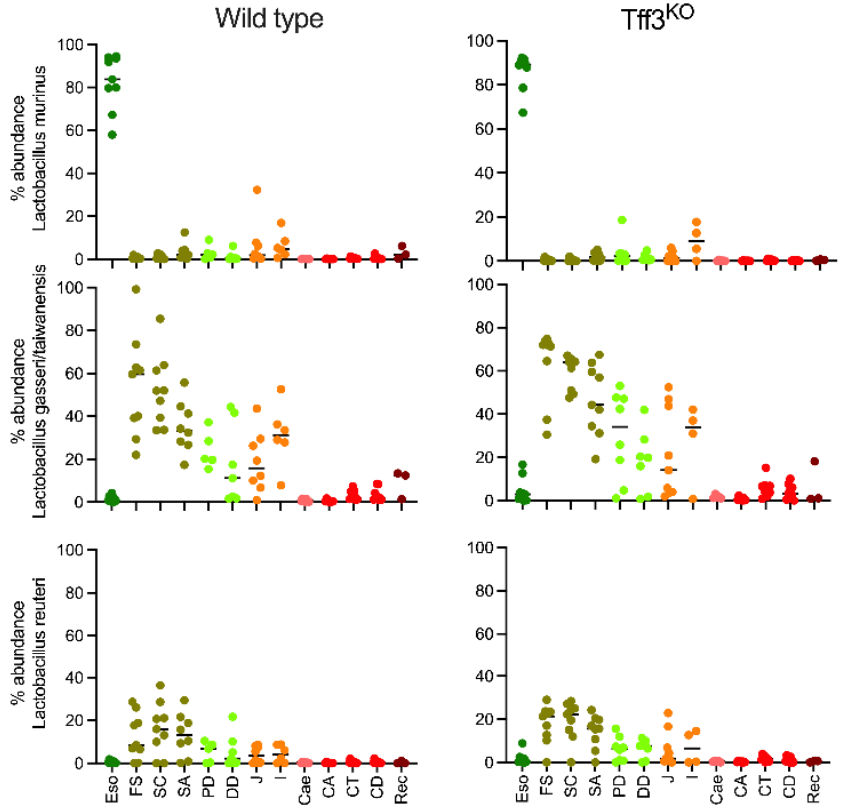
Figure 5. Relative abundance of phylotypes belonging to L. murinus , L. gasseri/taiwanensis and L. reuteri in each mouse and in each region; esophagus (Eso), forestomach (FS), stomach corpus (SC), stomach antrum (SA), proximal duodenum (PD), distal duodenum (DD), jejunum (J), ileum (I), caecum (Cae), ascending colon (CA), transverse colon (CT), descending colon (CD), and rectum (Rec).